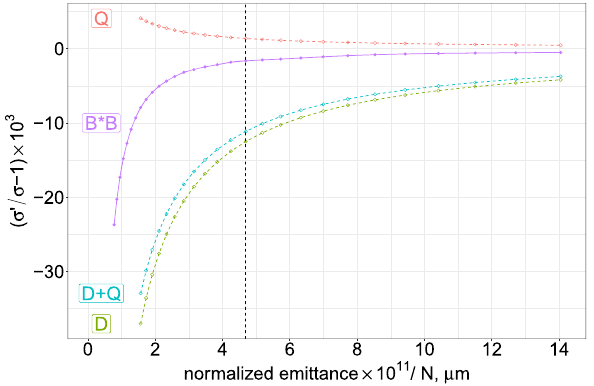
Fig. 11 The beam–beam cross-section bias (σ (cid:6) /σ − 1 ) × 10 3 deter- mined from (1.6) versus ˜ (cid:13)/ N × 10 11 , where ˜ (cid:13) is the normalized emit- tance ˜ (cid:13) = (cid:13)/( p / m p ) , identical for both bunches, m p is the proton mass and N = N 1 = N 2 is the number of protons. The bias is calculated for the single interaction point using B*B, analytic dipole (D), quadrupole (Q) approximations or their sum (D+Q). The tunes are Q x = 0 . 31, Q y = 0 . 32 and it is assumed that β x = β y = β . Under these condi- tions, σ (cid:6) /σ depends only on the combination ˜ (cid:13)/ N but not on (cid:13) , p , N or β individually. The vertical dashed line shows the value ˜ (cid:13)/ N × 10 11 for the bunch parameters from Table